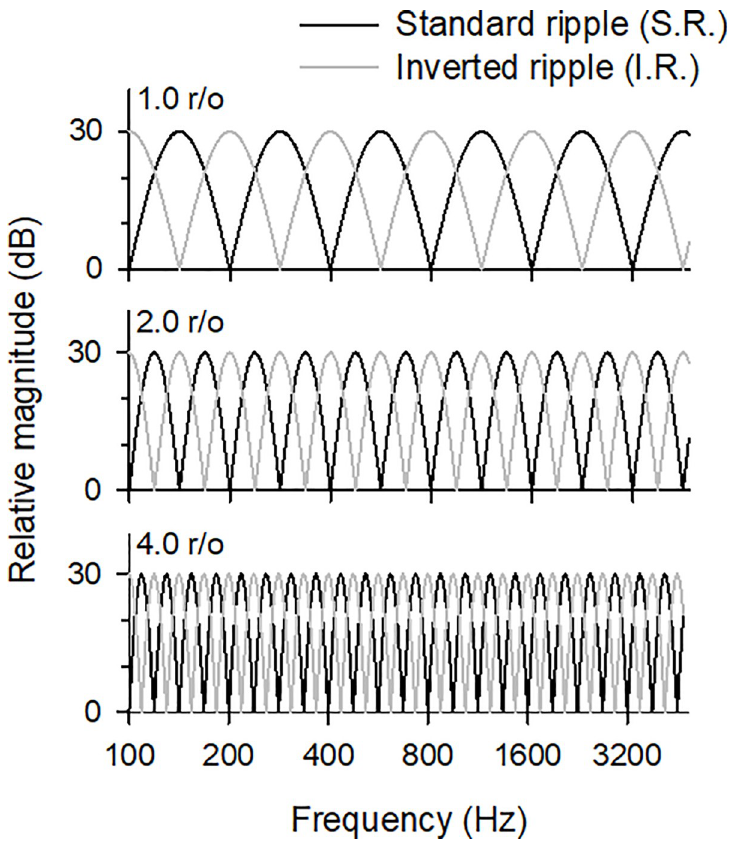
Fig 2. Spectra of the standard and inverted ripple noises with frequencies of 100–5000 Hz and ripple densities of 1.0, 2.0, and 4.0 r/o.